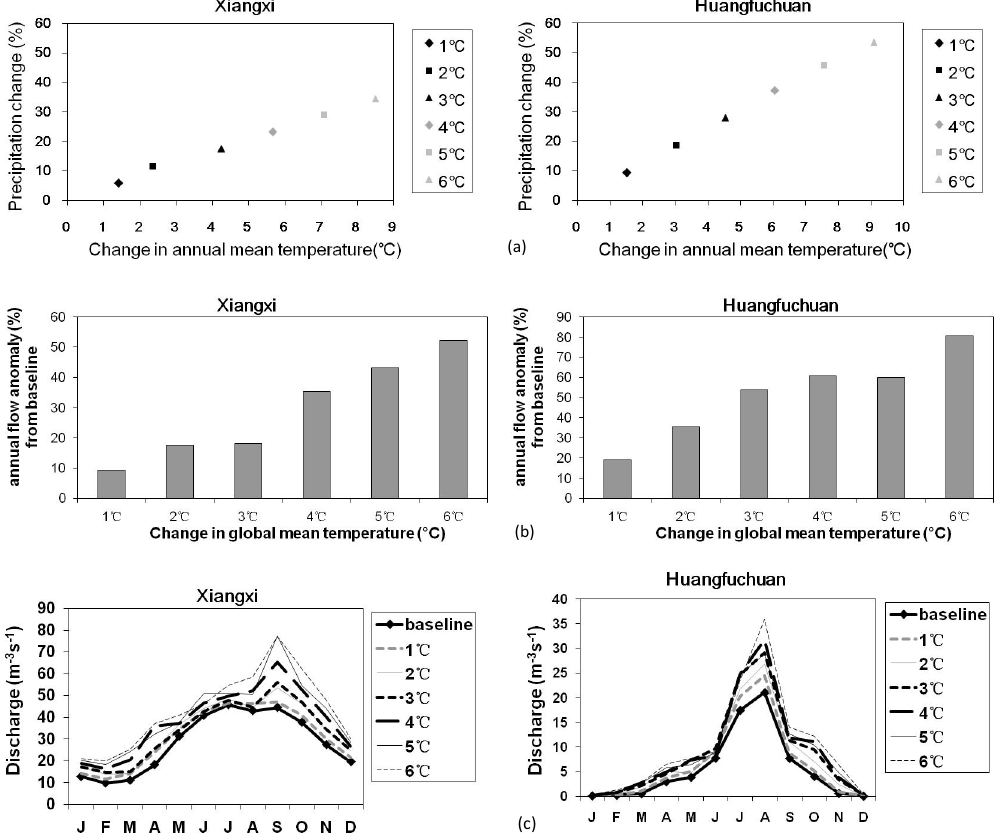
Fig.3. (a) Projected changes in annual mean temperature ( ℃ ) and annual precipitation (%), (b) annual and (c) monthly discharge for HadCM3 prescribed warming scenarios.